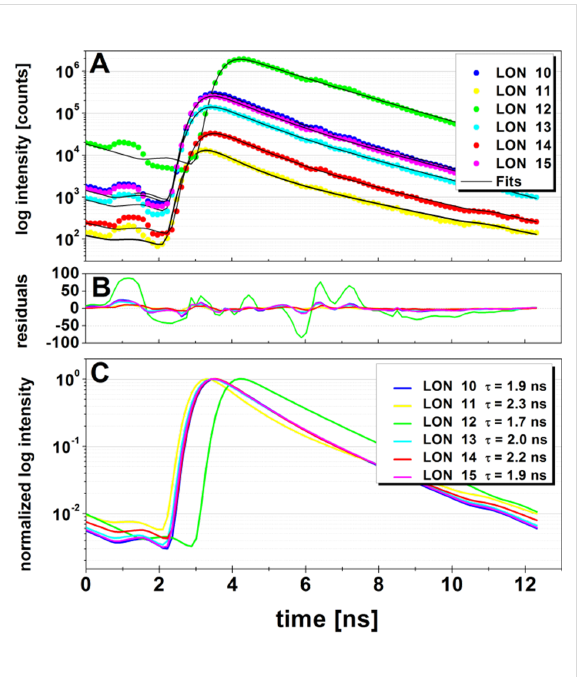
Figure 17: Fluorescence lifetime τ F values of the LONs 10 – 15 . A) Logarithmic imaging of fluorescence intensity–time decay of LONs 10 – 15 and the corresponding fitting curves (–). B) The residuals show some minor systematic errors (the color legend is the same as in A and C). C) Normalized logarithmic fluorescence intensity of the fitting curves.